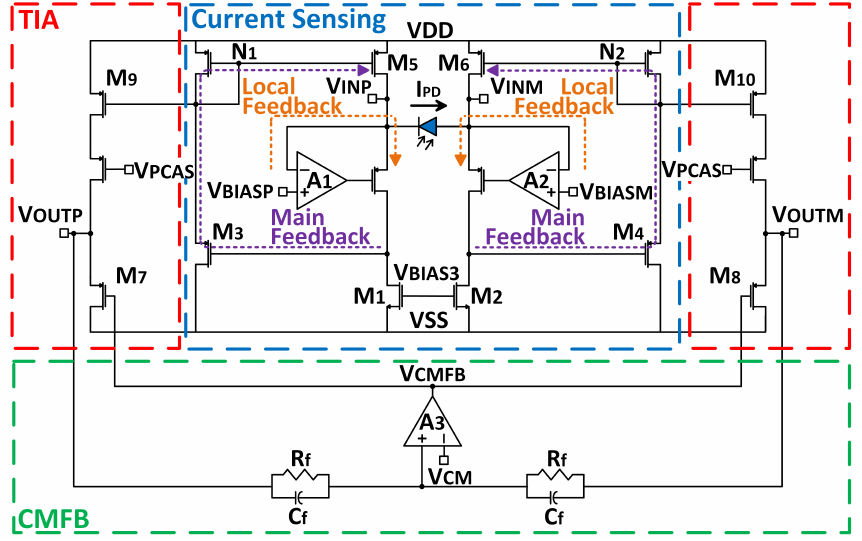
Figure 5. Transistor-level schematic of the TIA